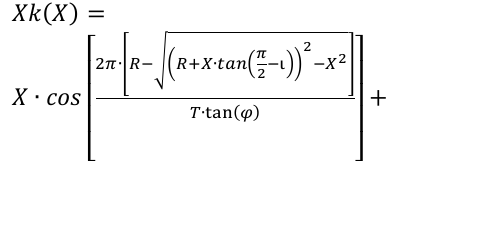
Fig. 1. Сhart of the three-fluted drill design The profile of the chip groove consists of two circles tangent to each other, as well as tangent to the inner diameter of the drill. The circle rk1 also touches the front surface located at an angle